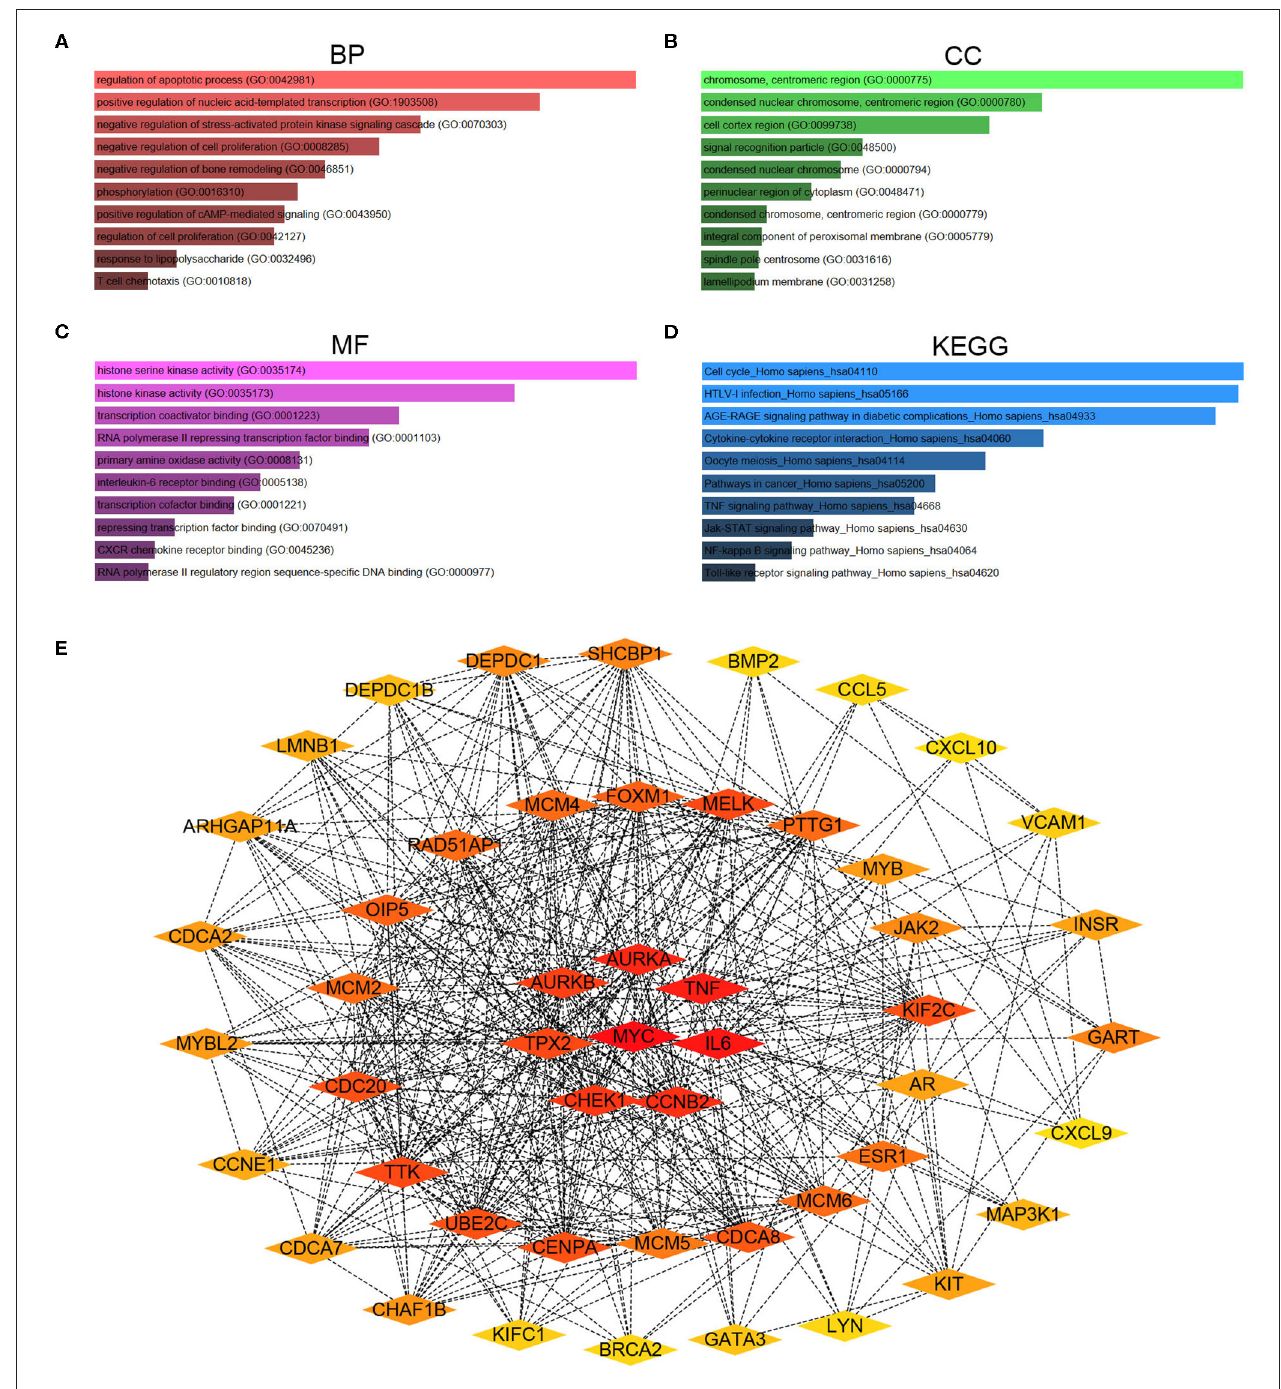
FIGURE 2 | Gene Ontology (GO) functional annotation, Kyoto Encyclopedia of Genes and Genomes (KEGG) pathway enrichment and protein-protein interaction (PPI) analysis for candidate genes. (A) The top 10 enriched biological process (BP) items for candidate genes. (B) The top 10 enriched cellular component (CC) items for candidate genes. (C) The top 10 enriched molecular function (MF) items for candidate genes. (D) The top 10 enriched KEGG pathway items for candidate genes. (E) The PPI network of the top 51 hub genes according to node degree.